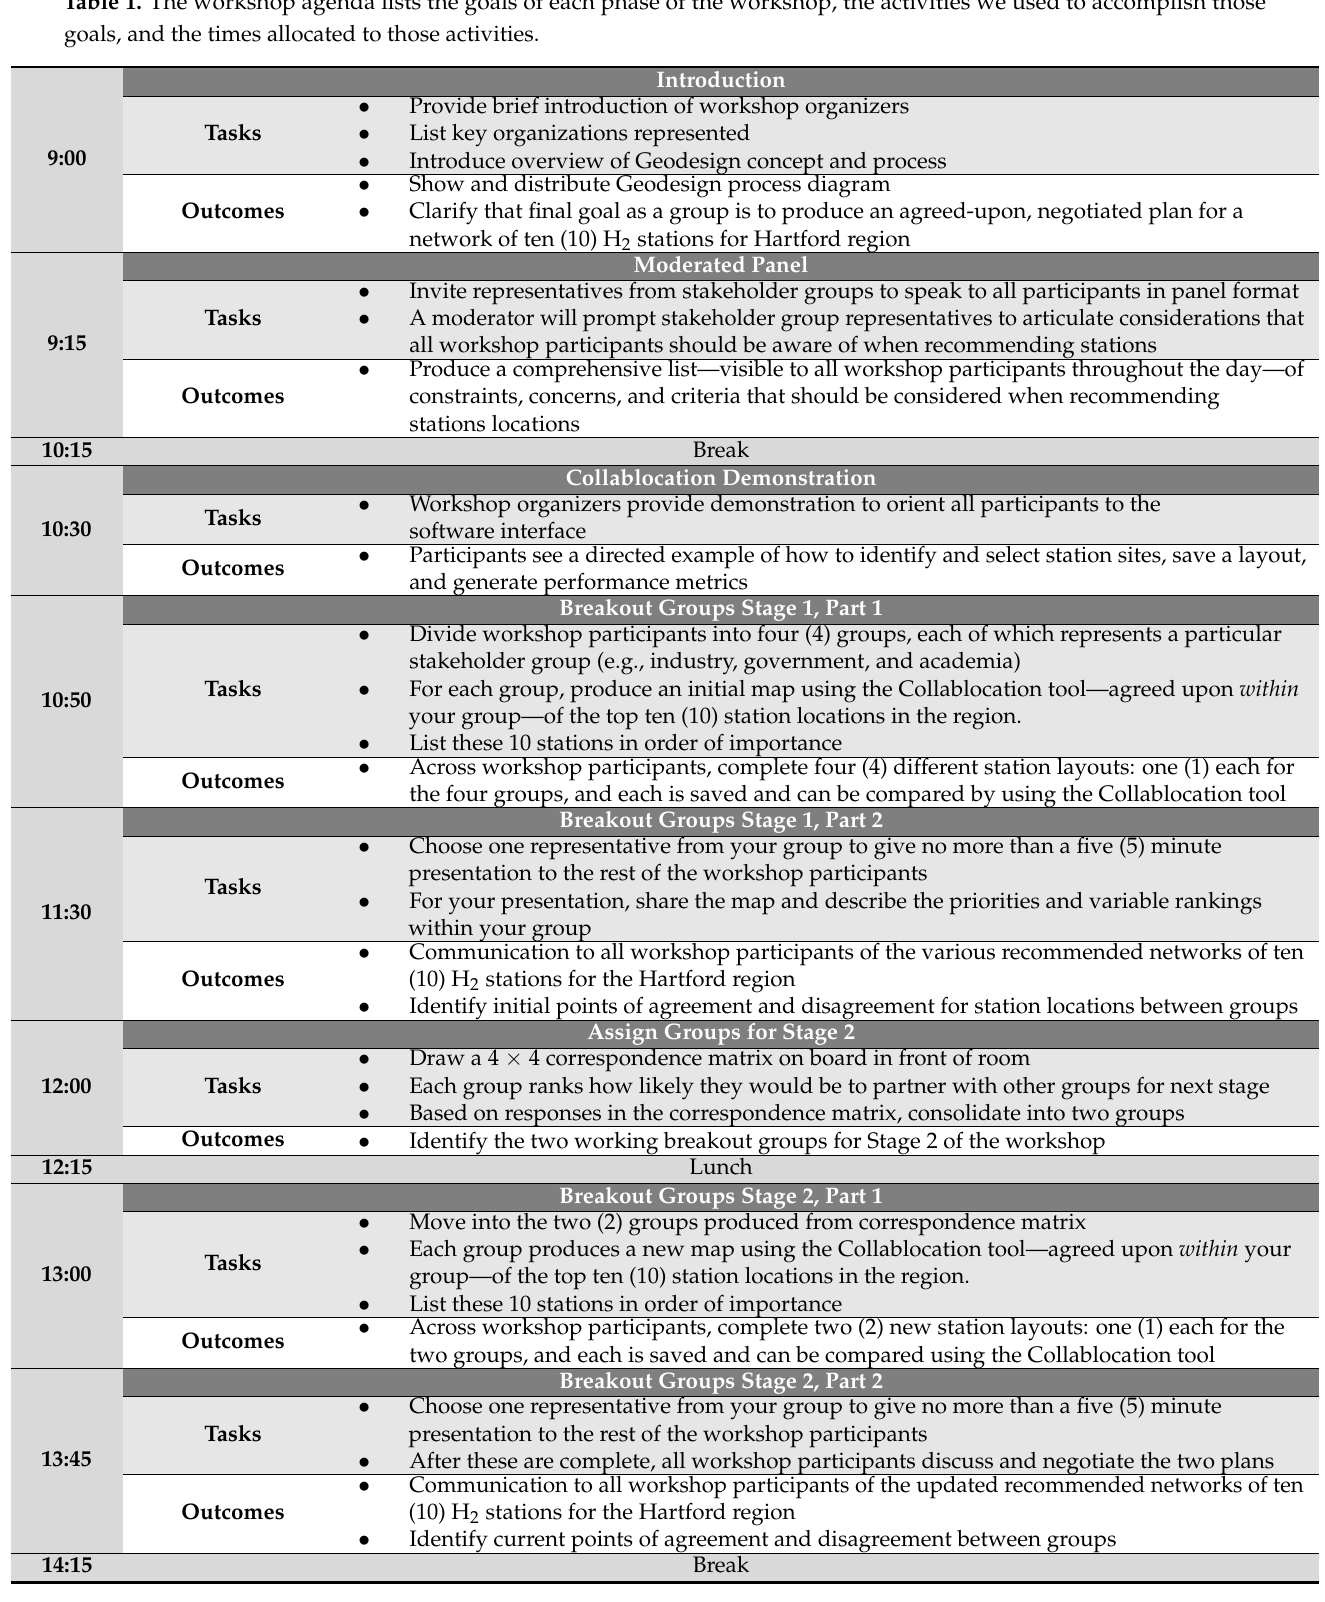
Table 1. The workshop agenda lists the goals of each phase of the workshop, the activities we used to accomplish those goals, and the times allocated to those